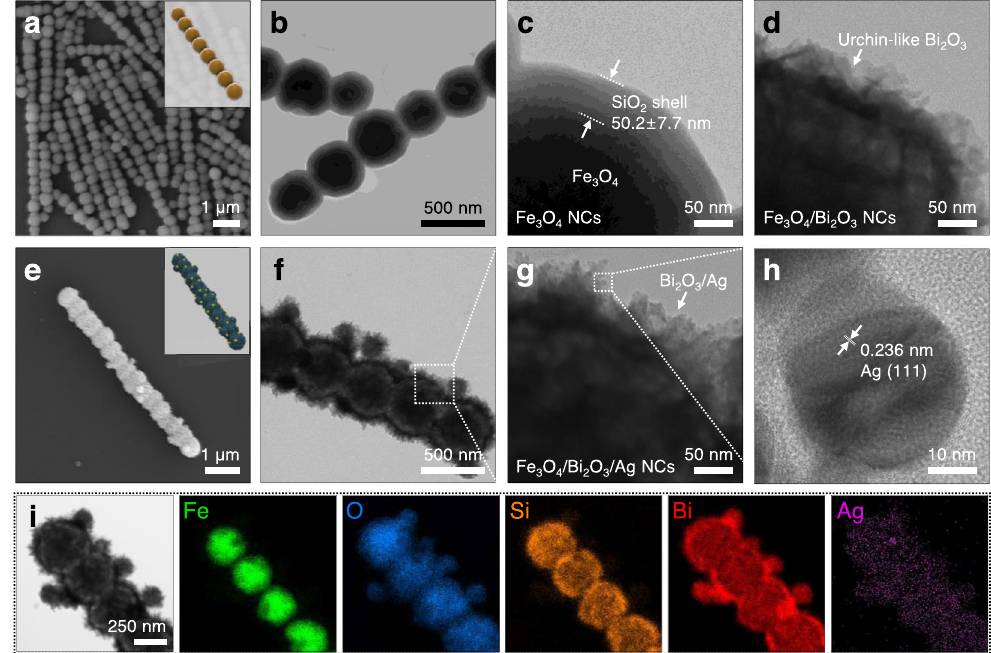
e – h Representative SEM image ( e ) and different magni fi cation TEM ( f , g ),